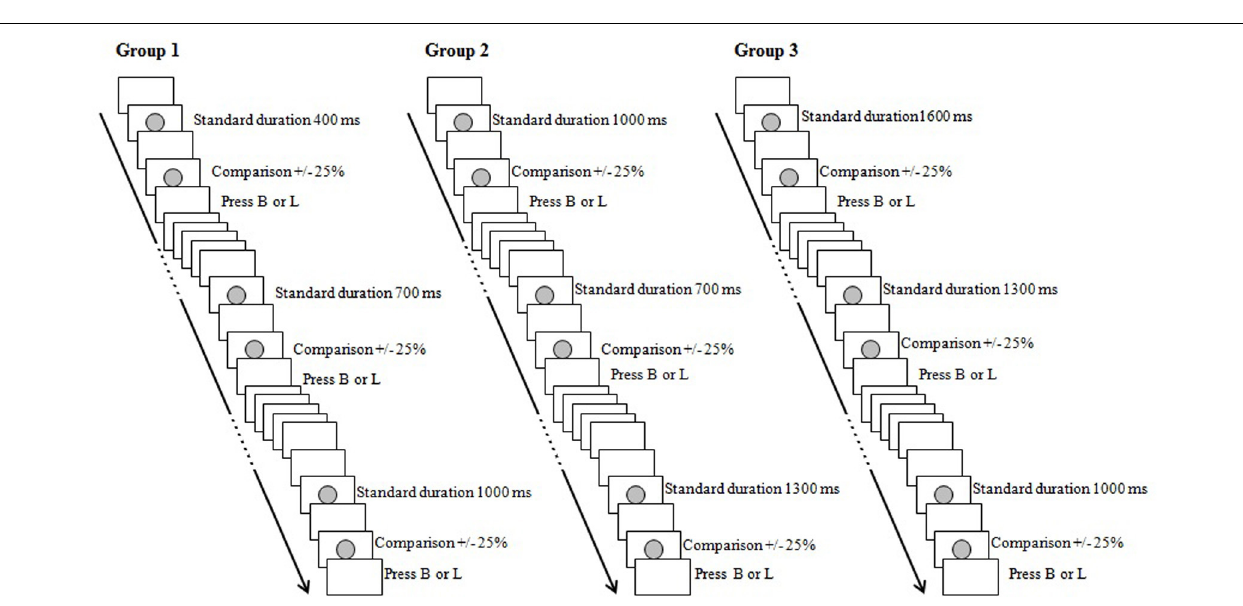
[ F (1 , 53) = 19 . 02, p < 0 . 001, η 2